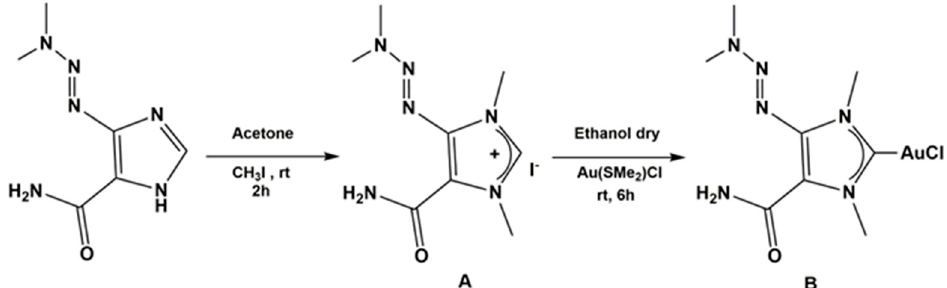
Figure 2. Synthesis of proligand ( A ) and (NHC d ) AuCl complex ( B ). Synthesis of proligand: N, N ′ dimethyl-4-[(E)-dimethylaminodiazenyl]-5-carbox-